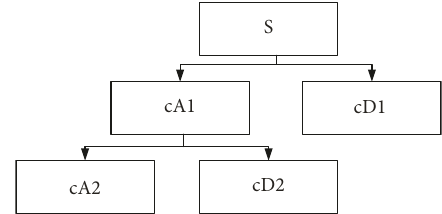
Figure 3: Schematic diagram of wavelet